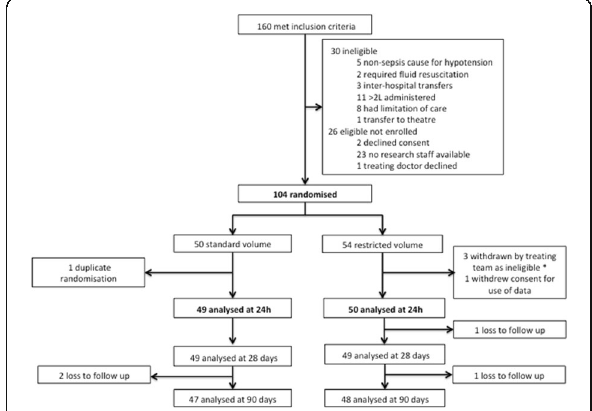
Fig. 2 (abstract P21). Consort flowchart of participants through the trial. *Met exclusion criteria on basis of limitation-of-care order